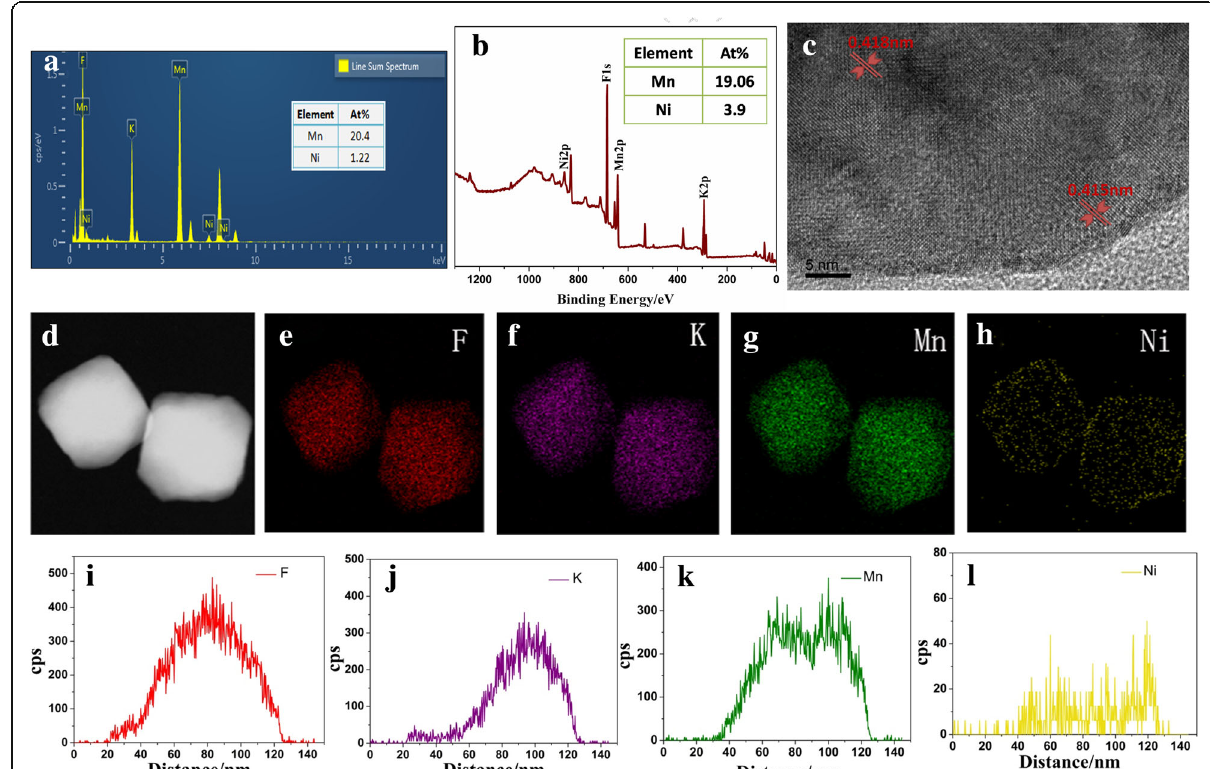
Fig. 3 The further supplement and verification of the structure and morphology of K(Mn 0.95 Ni 0.05 )F 3 nanoparticles ( a corresponds to EDS image; b corresponds to XPS image; c corresponds to HRTEM images; d corresponds to the electron image; e , f , g , and h correspond to F, K, Mn, and Ni elements of mapping images, respectively; i , j , k , and l correspond to F, K, Mn, and Ni elements of line scanning curves,